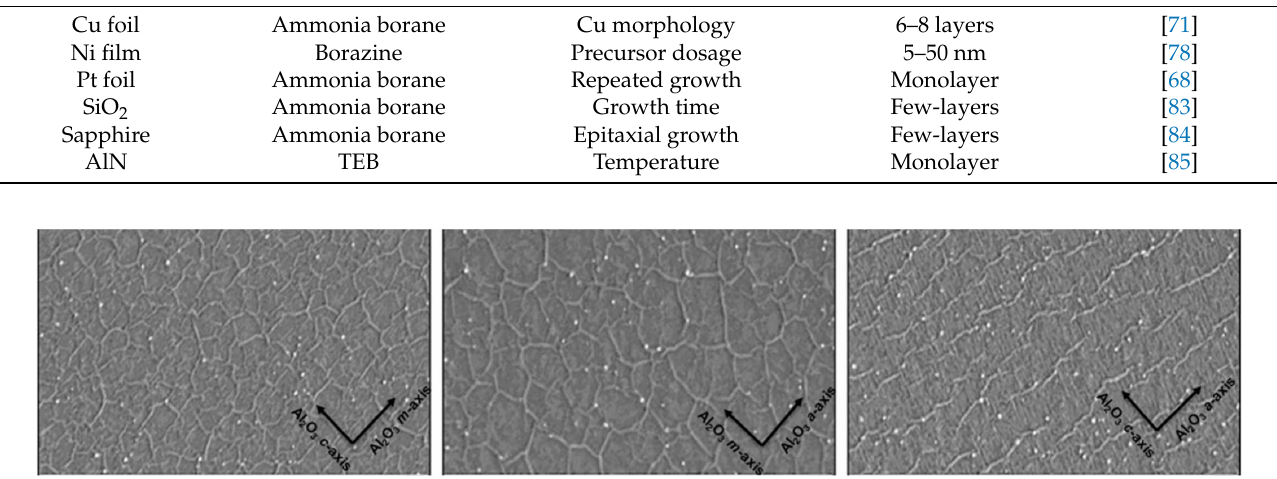
Figure 19. AFM images of h-BN grown on a-plane, c-plane, and m-plane sapphire [82].